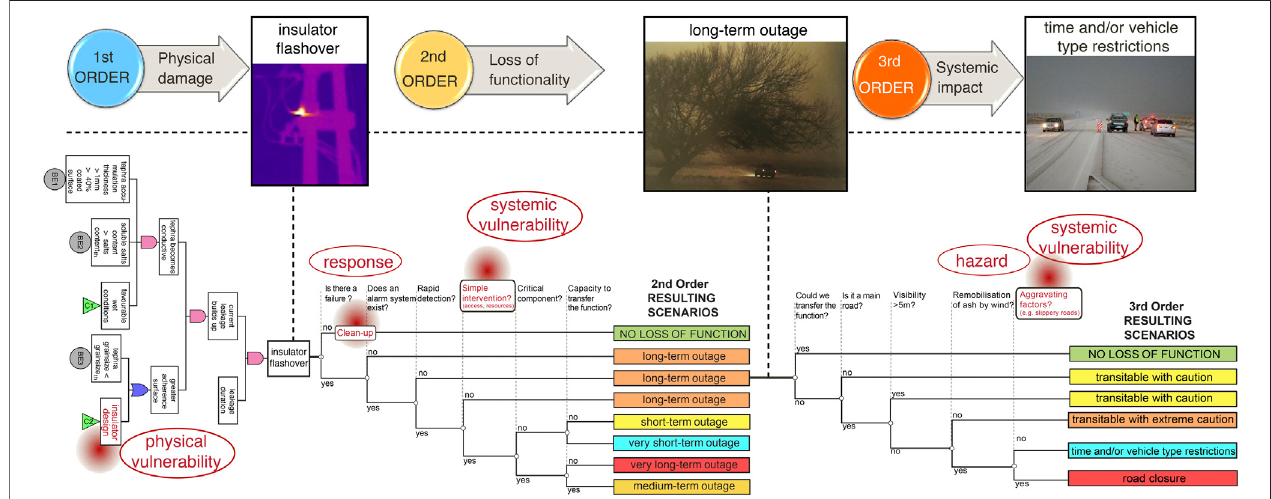
FIGURE 10 | Integrative impact assessment – Step IV: Identifying critical points. The bow-tie structure corresponds to the connection of the logical tools shown in Figures 8 , 9A,B associated with the cascading impacts on the power system. As an example, the identi fi ed risk components (i.e., hazard, physical and systemic vulnerabiltyandcapacityofresponse)areshown.Redcirclesindicatevulnerabilityhotspotsthatmostlikelyincreasetheseverityofimpacts.Photocourtesy:Cooperative of Electricity of Bariloche (insulator fl ashover), Chino Leiva (power supply disruption), Diario de Río Negro, http://www.rionegro.com.ar/diario/ (road system